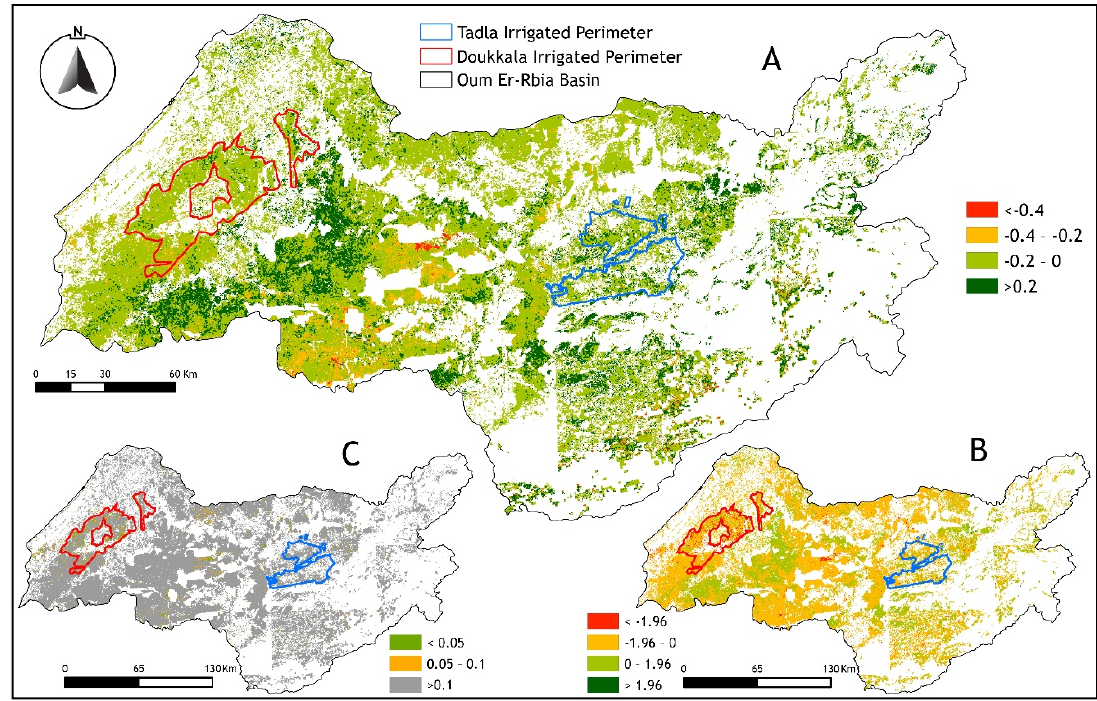
Figure 8. Start of season time (TSOS) trend: Sen’s slope values ( A ); Mann–Kendall Z ( B ); and p-value intervals ( C ).